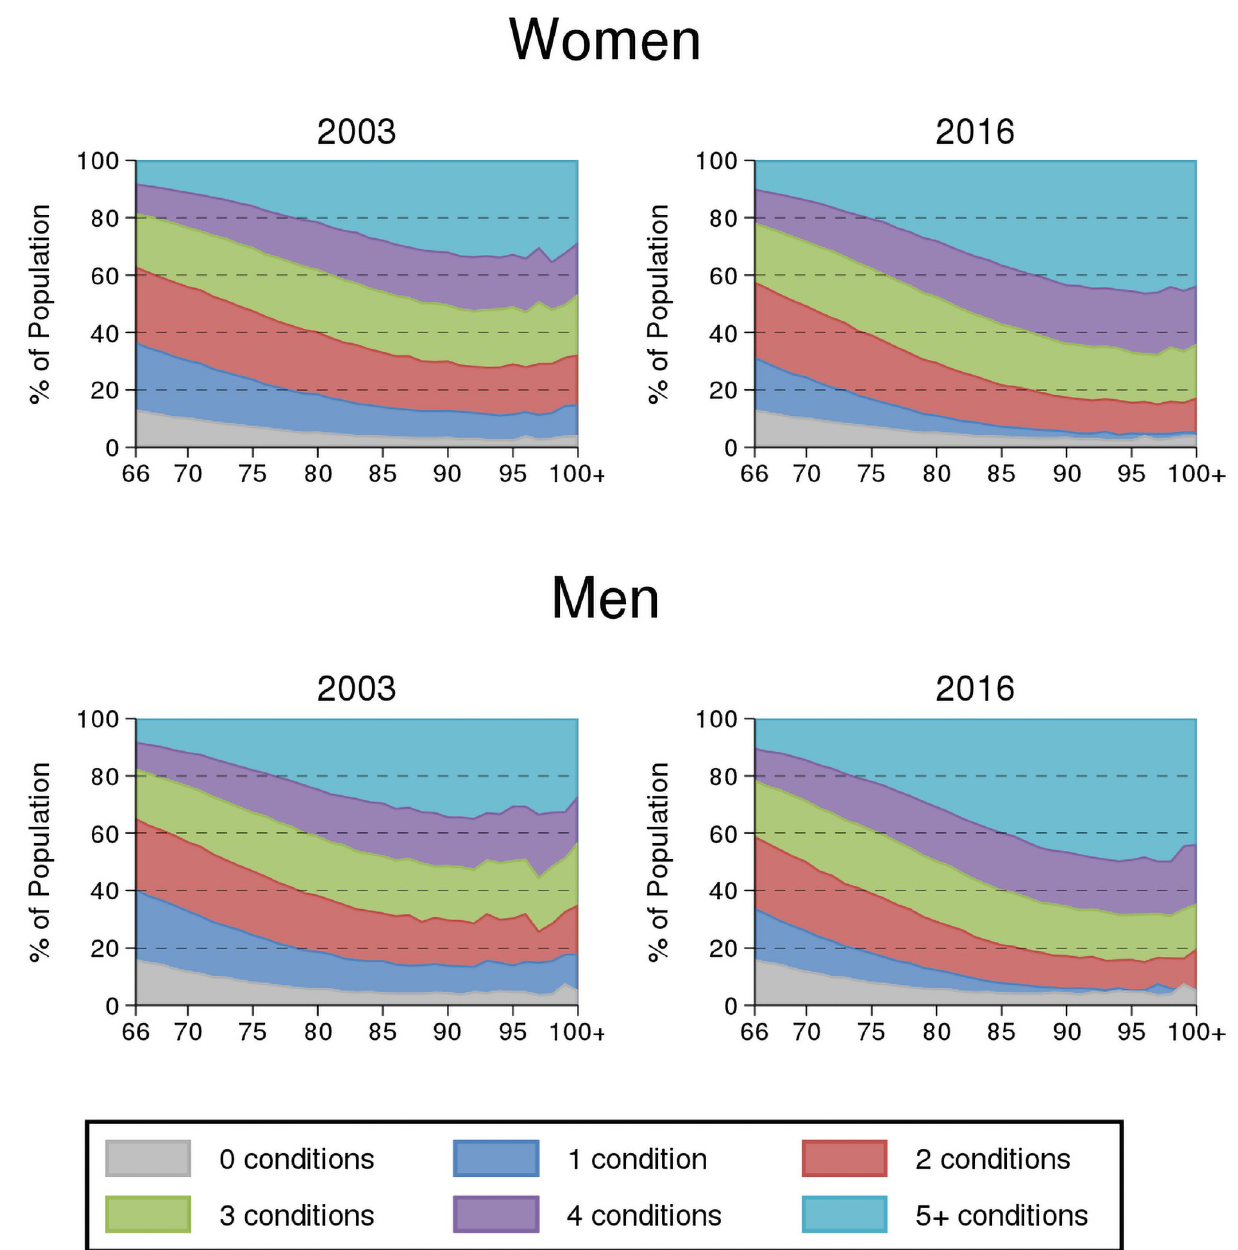
Fig 1. Distribution of level of multimorbidity by age among older adults (age � 66 years) in Ontario, Canada: 2003 vs 2016 for women and men.